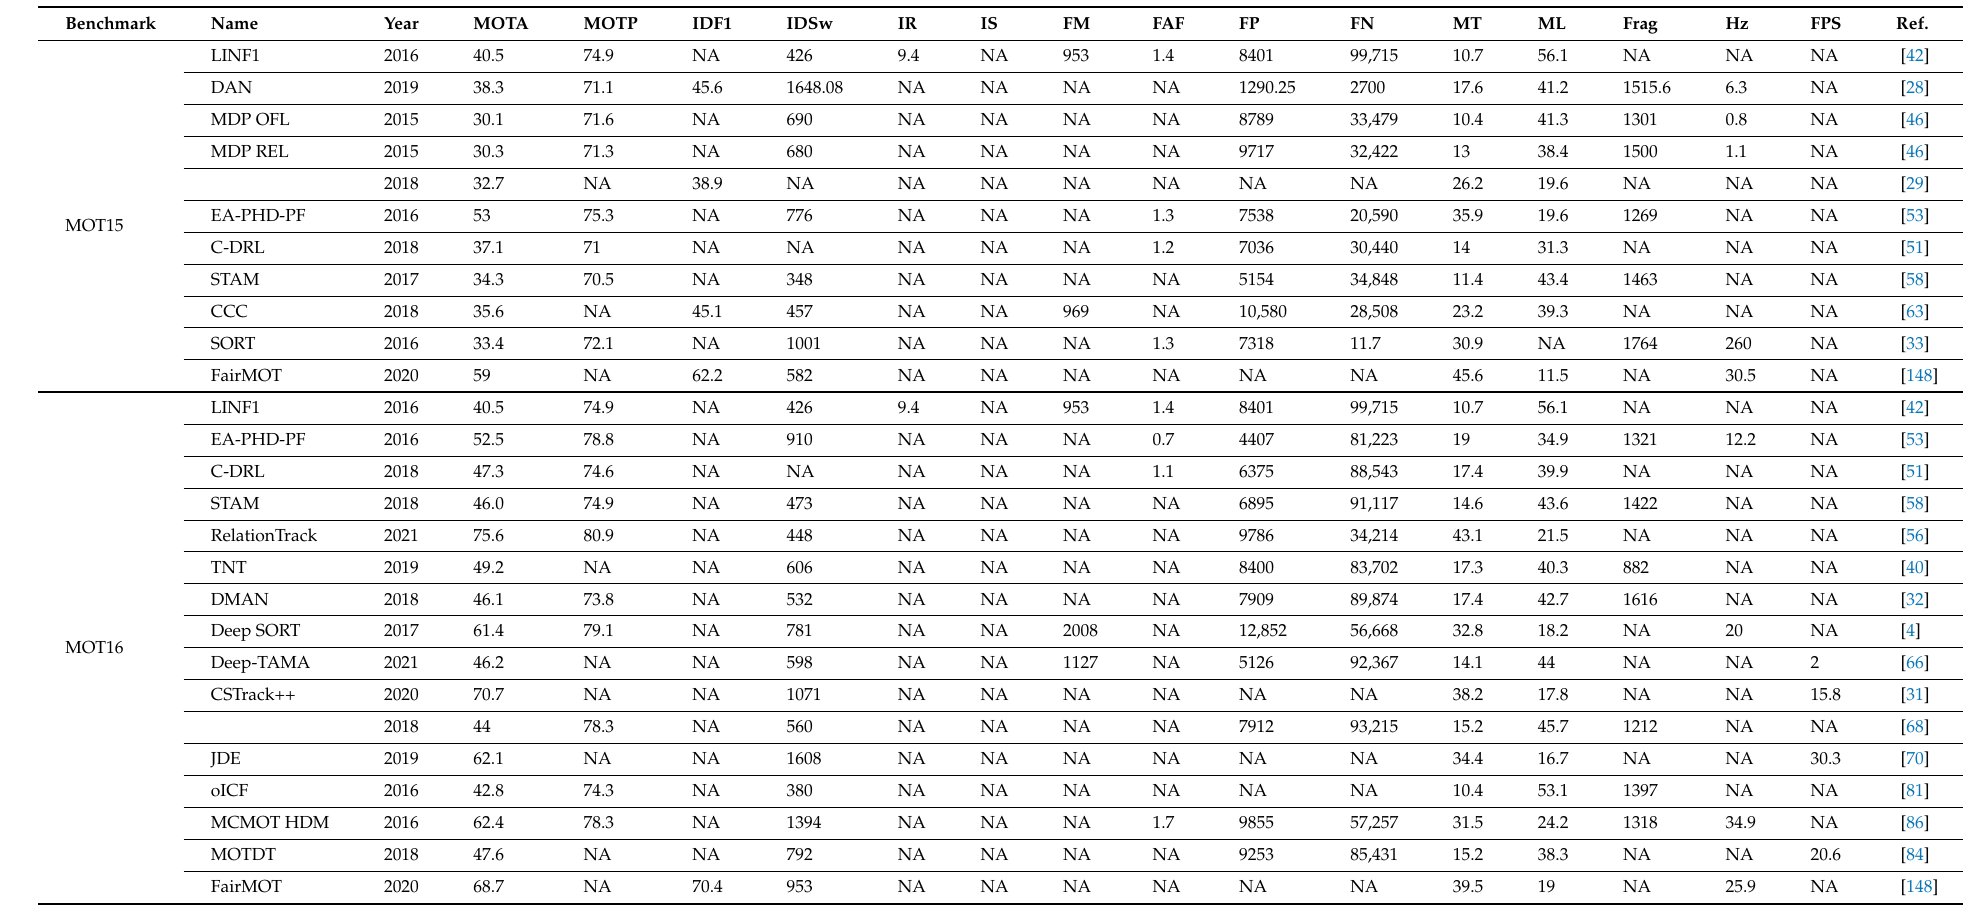
Table A1. Performance on the MOT benchmark, which includes the MOT15 [8], MOT16 [141], and MOT17